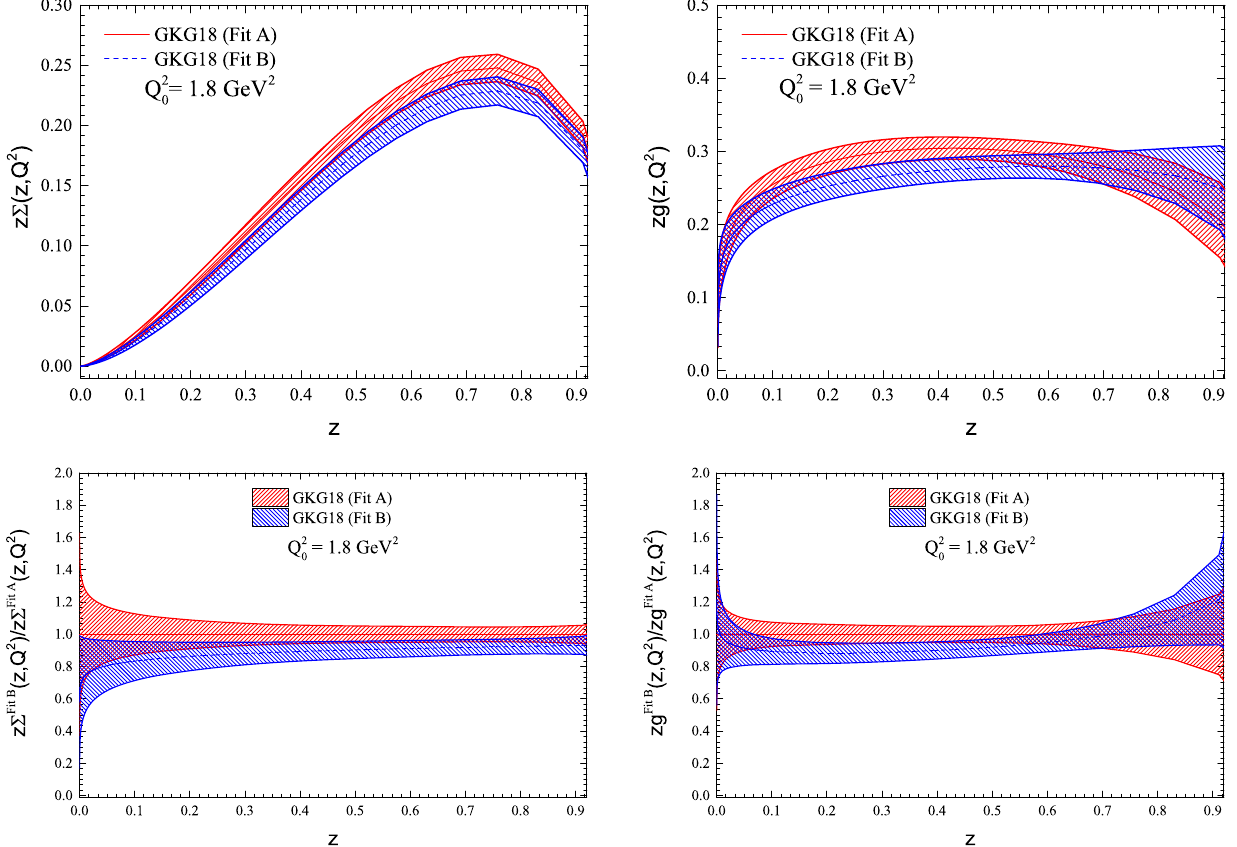
(cid:10) ) = ) + ¯ q ( z , Q 2 ) ] (left) and gluon zg ( z , Q 2 z [ q ( z , Q 2 q = u , d , s 0 0 0 = 1 . 8GeV 2 . The error bands correspond to the experimental 0